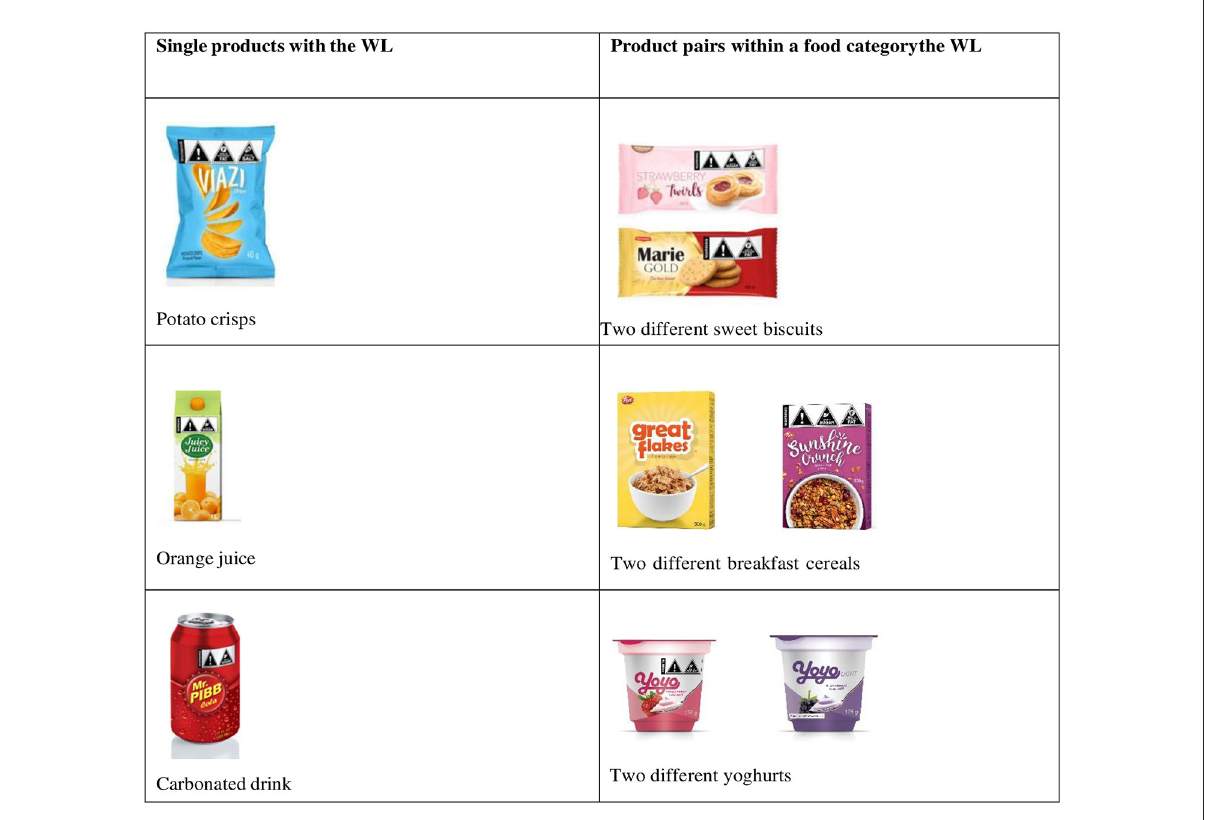
FIGURE2 Images used during data